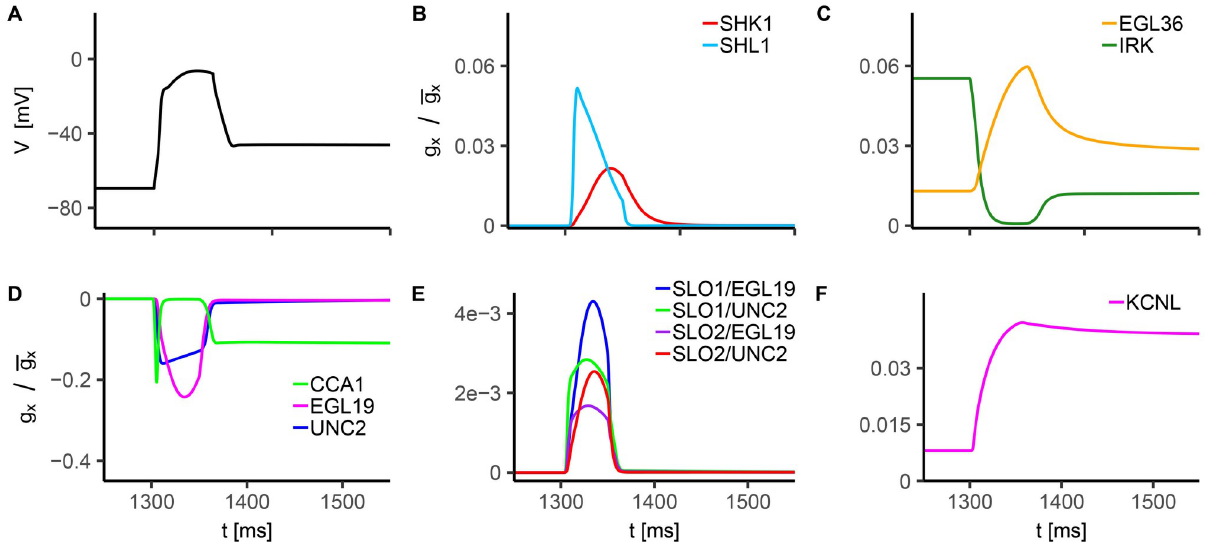
Fig 8. In silico analysis of RMD voltage response to current injection. The stimulation protocol consists in a single 10 pA current step with a duration = 0 pA. A) WT Voltage response to 10 pA current injection . B-F) Normalized conductance for modeled of 50 ms. The holding current is I h currents . In these panels we report the time evolution of the normalized conductance of each modeled current for WT current clamp simulation shown in panel A. The normalized conductance is defined as the product of the activation and inactivation variables of the considered ion current. Panels B and C show g = � g for voltage-gated K + currents, panel D for voltage-gated Ca 2+ currents, and panels E and F for calcium-dependent K + currents. The x x values for CCA1, UNC2 and EGL19 currents are multiplied by -1 to reproduce the sign of the associated currents. g = � g x